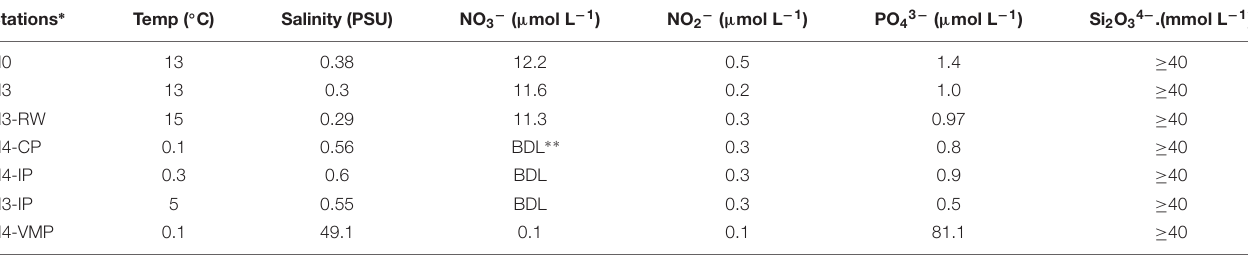
TABLE 1 | Physico-chemical characterization during sample collection at selected stations in Salar de Huasco during November 15, 2013. Stations ∗